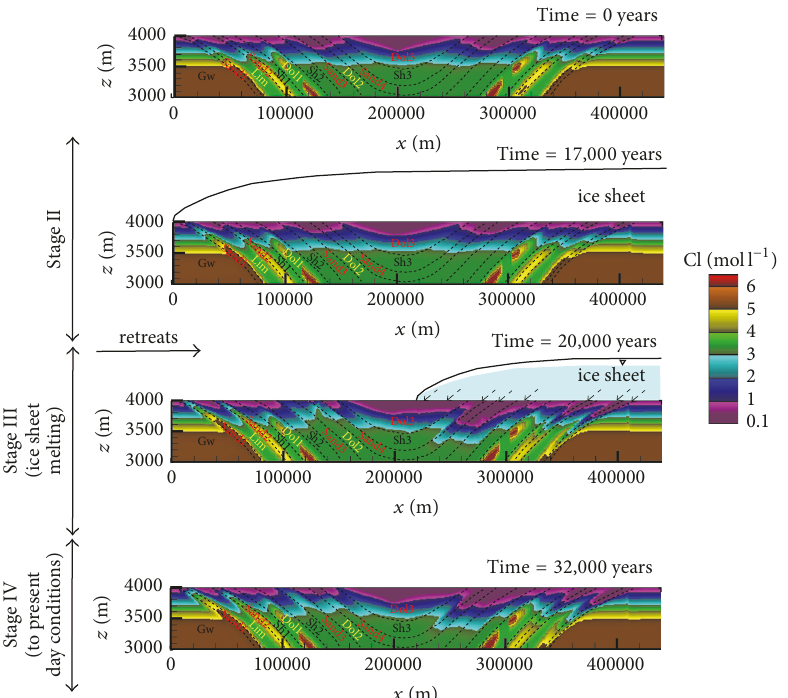
Figure 5: Spatial Cl concentration distributions at different times for the base case simulation (i.e., at 0, 17,000, 20,000, and 32,000 years), corresponding to the initial condition, the end of Stage II, Stage III, and the final condition.